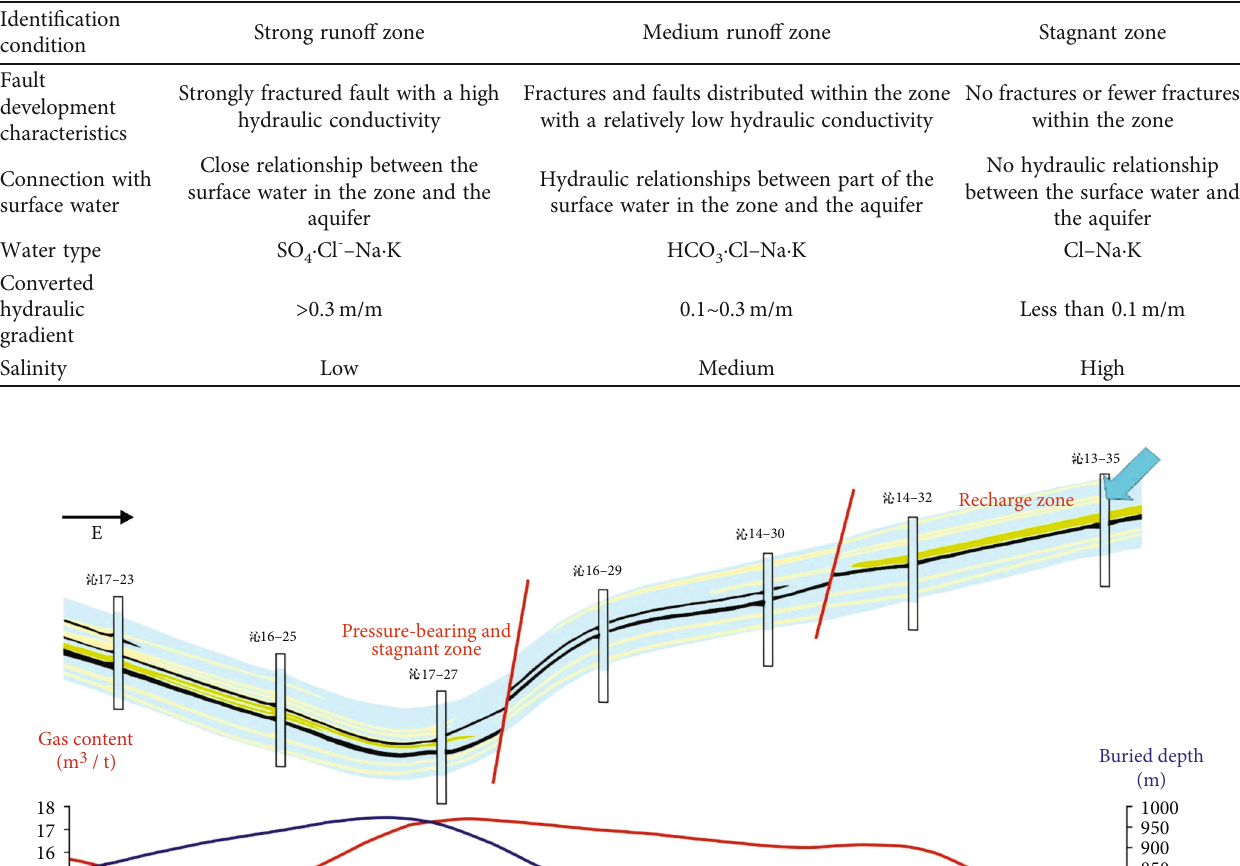
Table 1: Conditions for identifying di ff erent hydrodynamic zones.